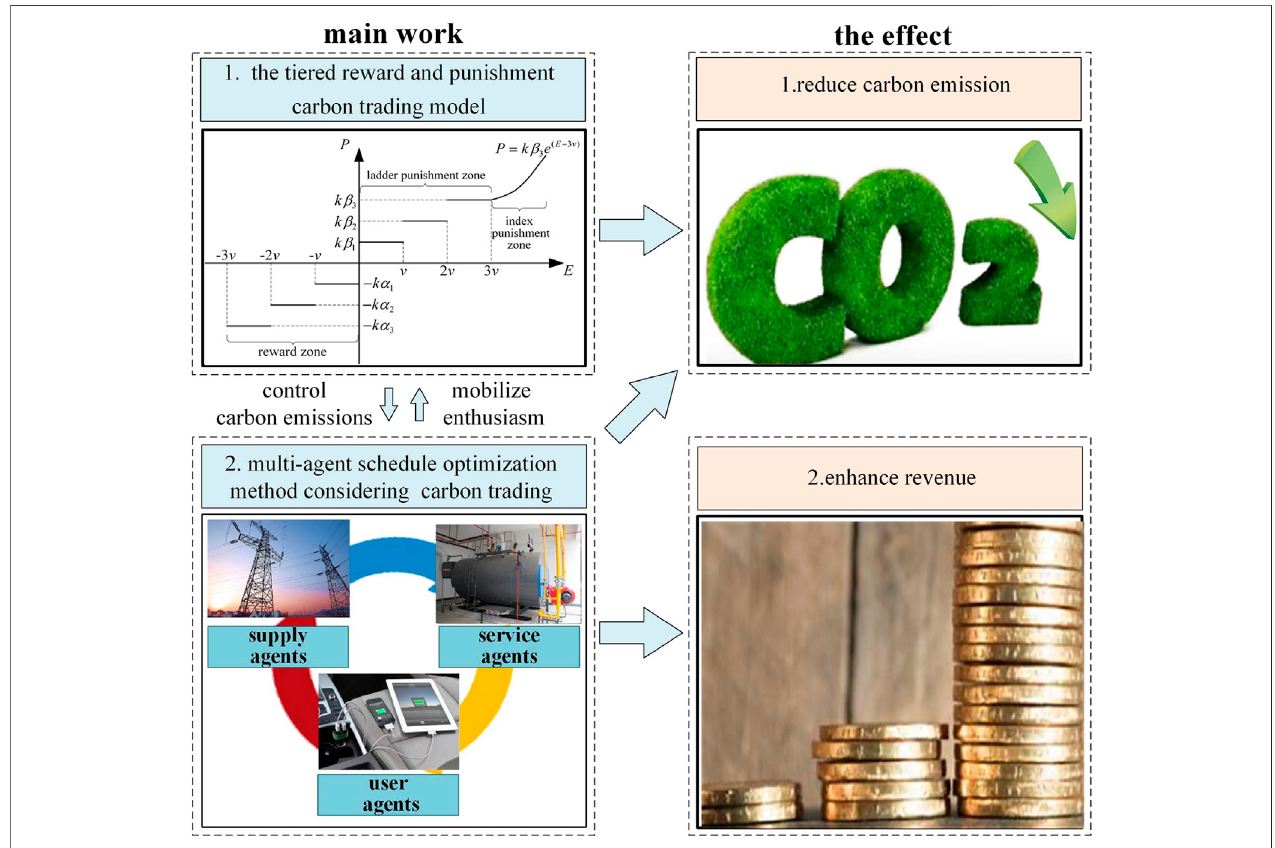
FIGURE 2 | The main work of this paper and the